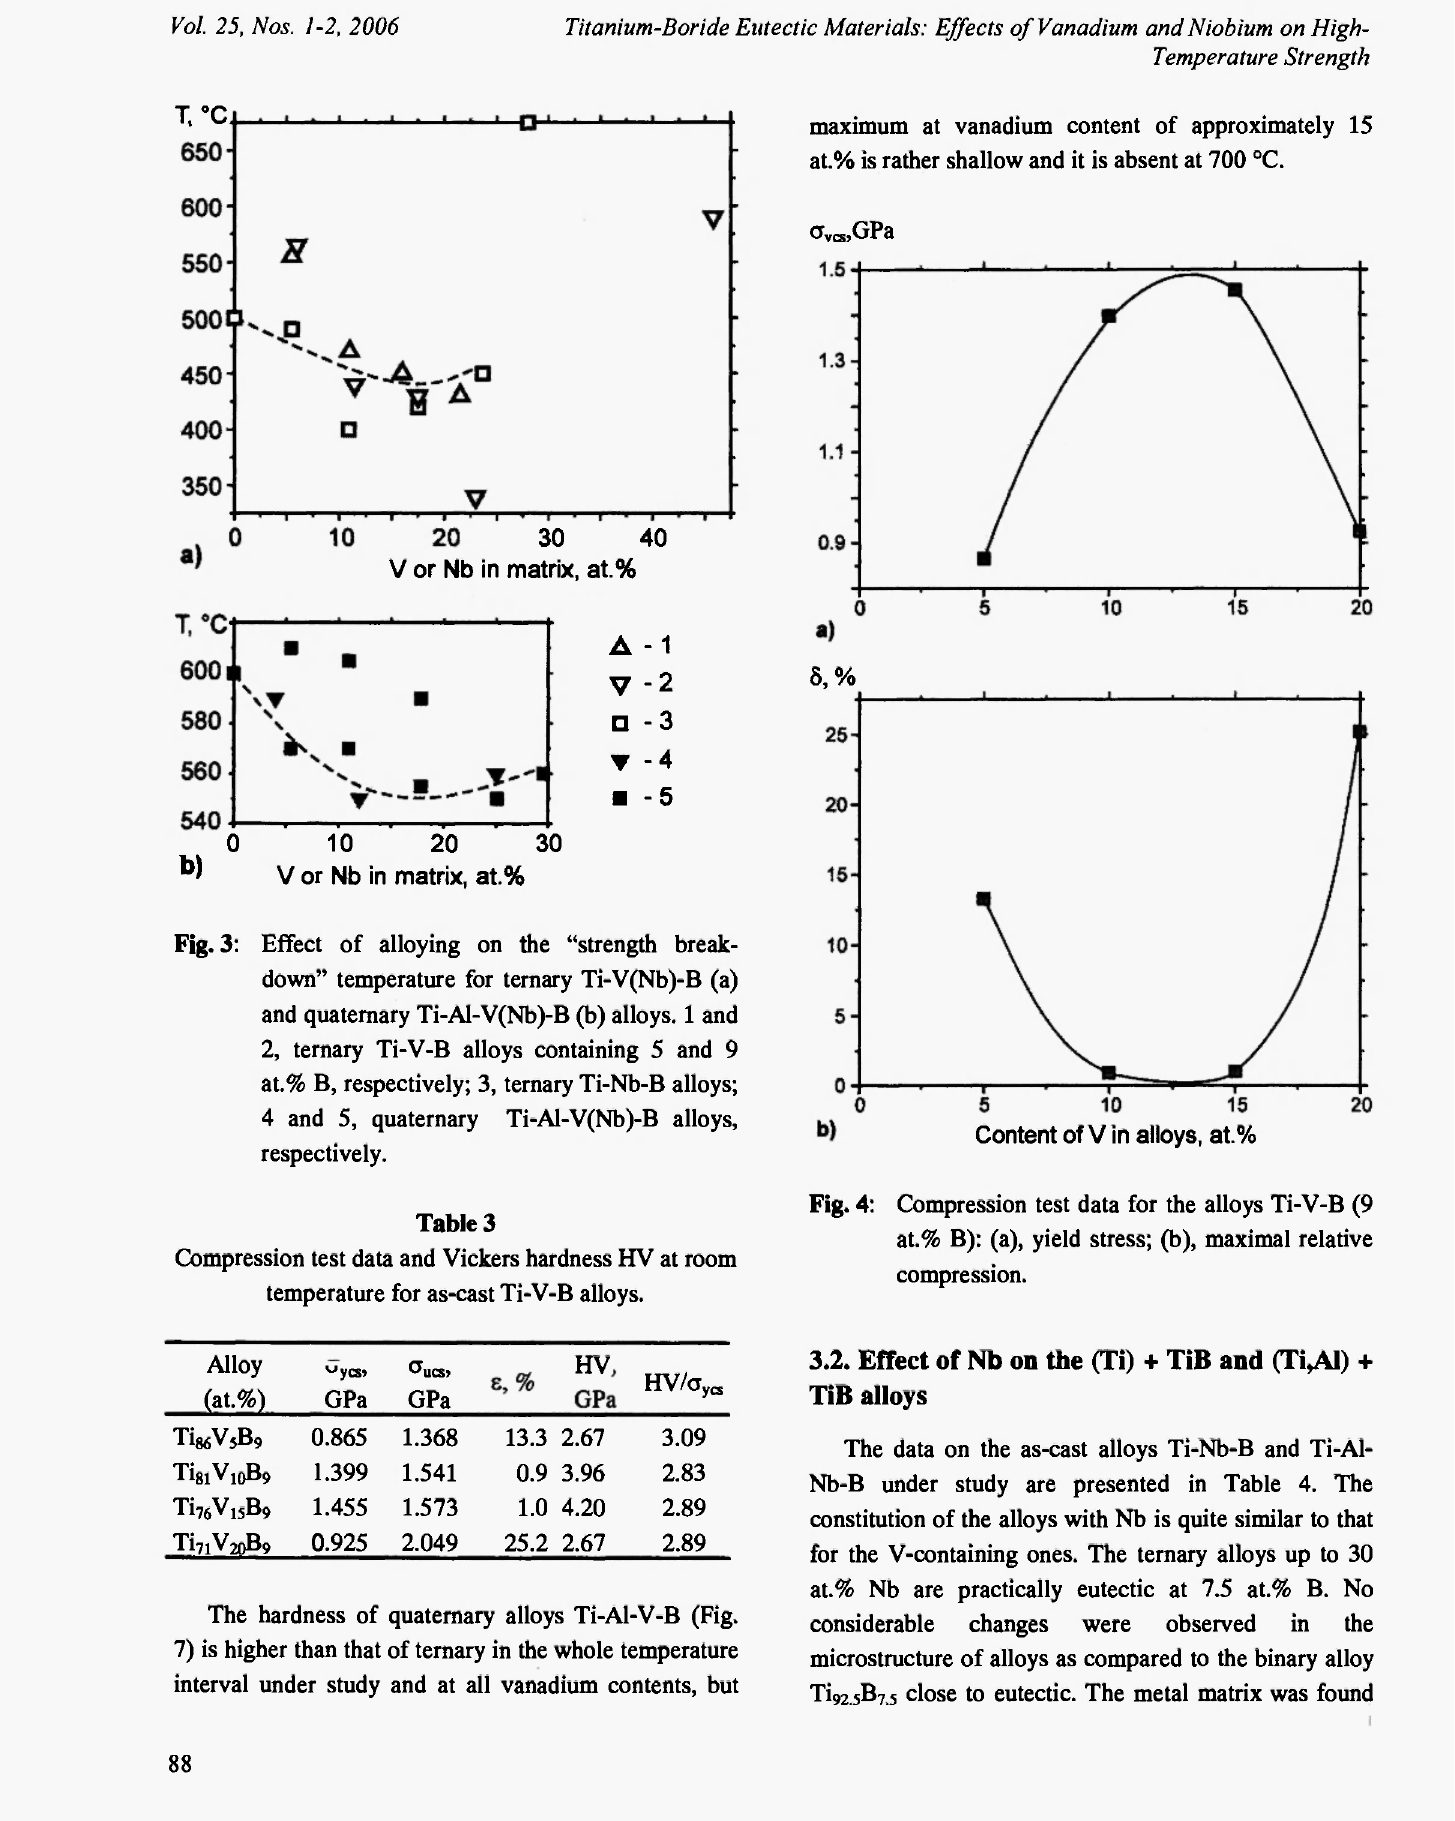
Content of V in alloys, at.% Fig. 4: Compression test data for the alloys Ti-V-B (9 at.% B): (a), yield stress; (b), maximal relative